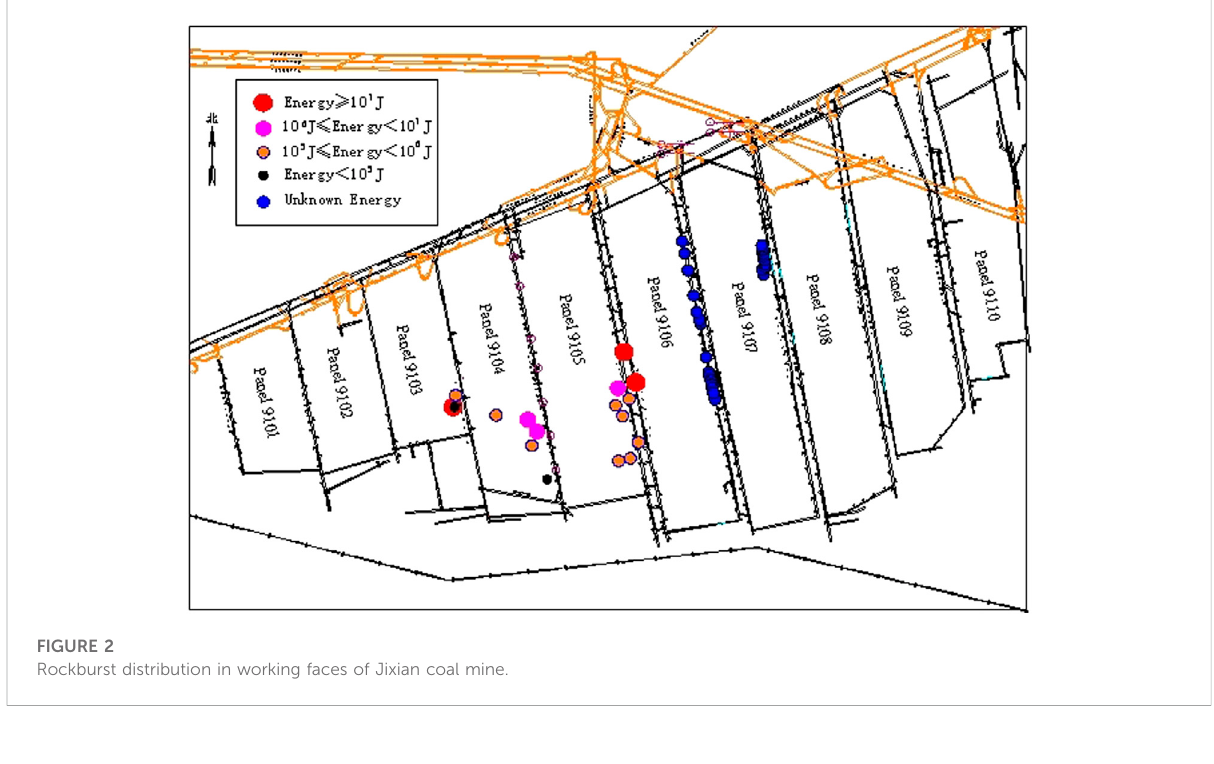
FIGURE 2 Rockburst distribution in working faces of Jixian coal mine.